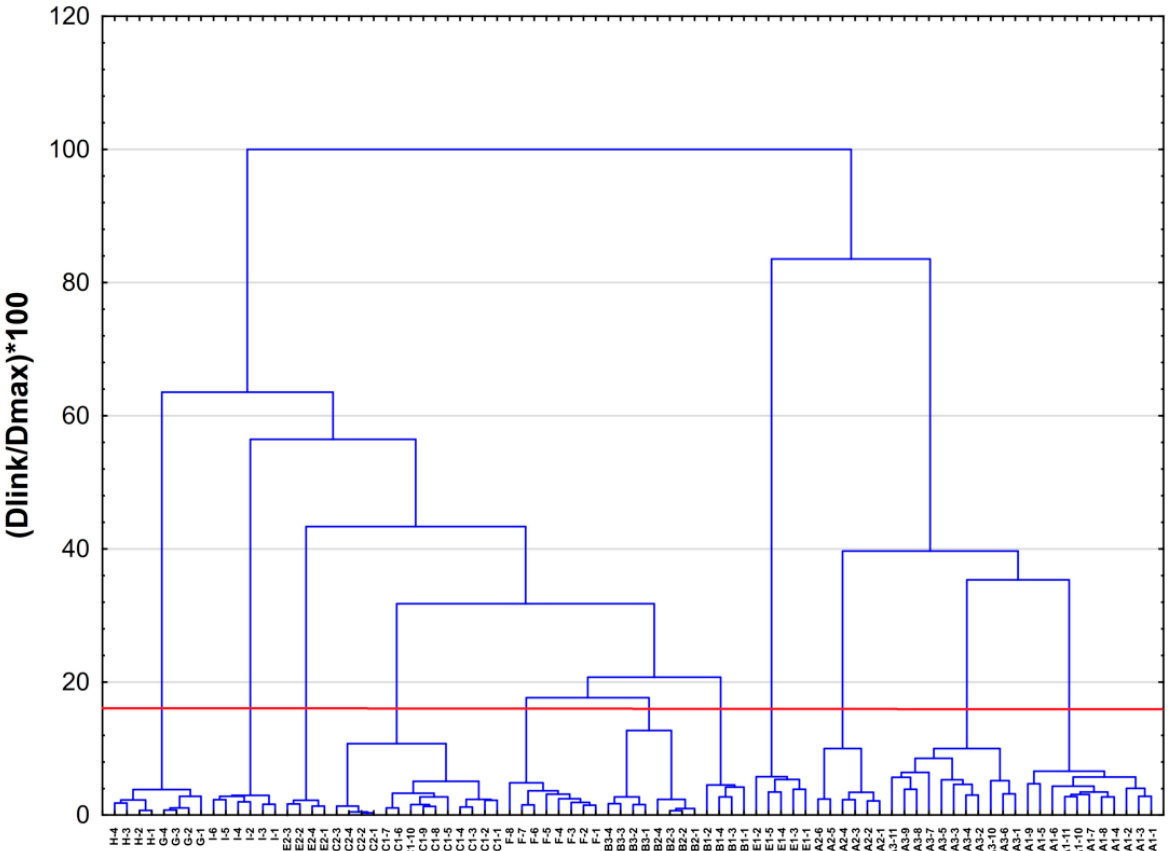
Figure 1. Dendrogram of samples of cryptic species of A. pinguis (C, E, G, H, and I) compared with the remaining species of A. pinguis examined in a previous study [35]. The dendrogram was constructed based on the Euclidean distance according to Ward’s linkage method. The dendrogram was based on all of the detected compounds in the samples. The transverse line indicates the intersection of the dendrogram according to the Mojena index.